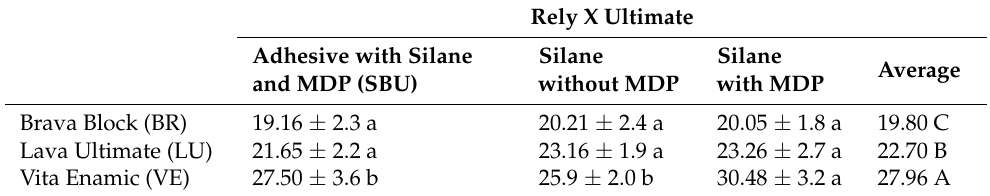
Table 4. Means and standard deviations of bond strength values (MPa) by micro-shear test with Rely X Ultimate cement for the experimental groups.